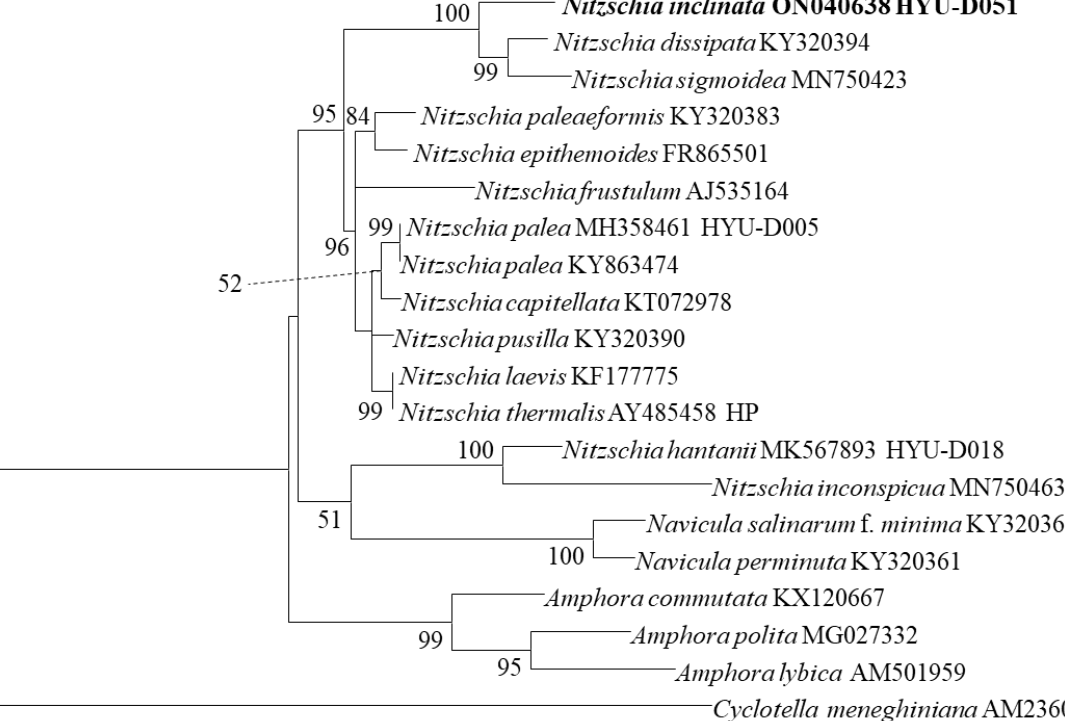
Figure 13. rbcL phylogenetic tree by maximum likelihood method of Nitzschia inclinata sp. nov. and other species molecular position. The tree with the highest log likelihood ( − 2490.51) is shown. The percentages of trees in which the associated taxa clustered together are shown next to the branches.